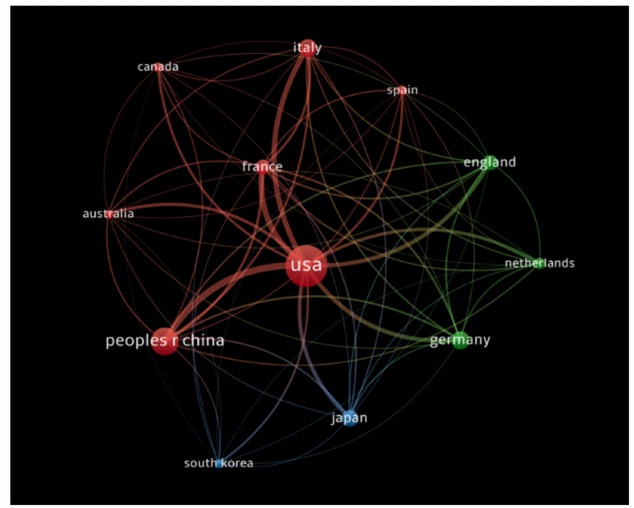
Figure 7. Bibliometric analysis of the countries in the publications of immunotherapy in CRC showing countries receiving top citations, where the size of nodes indicates the number of citations received.